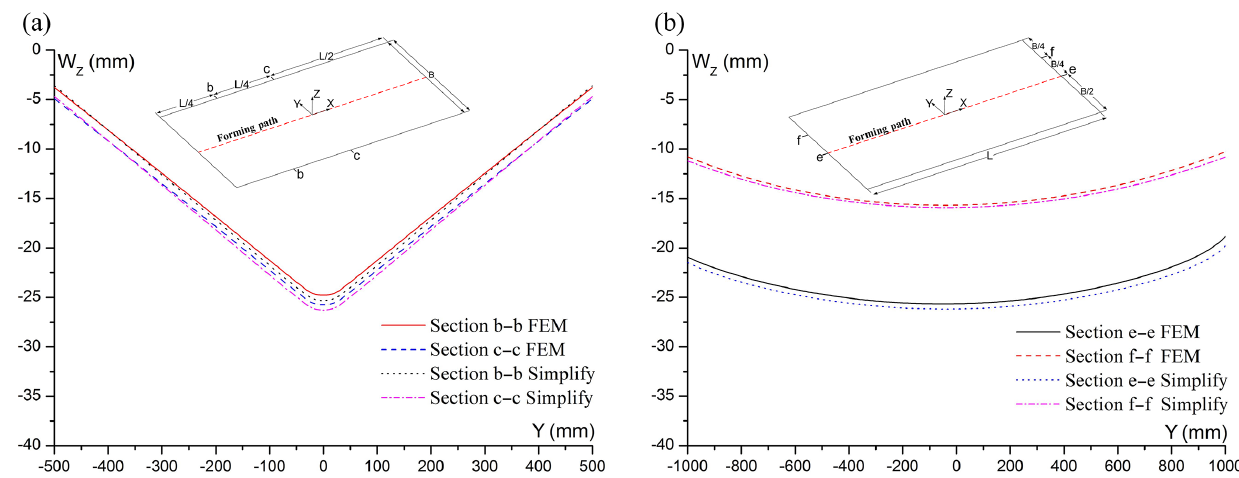
Figure 10. Comparison of deformation between elastoplastic FEM and simplified deformation simulation method. (a) Results from lateral sections. (b) Results from longitudinal